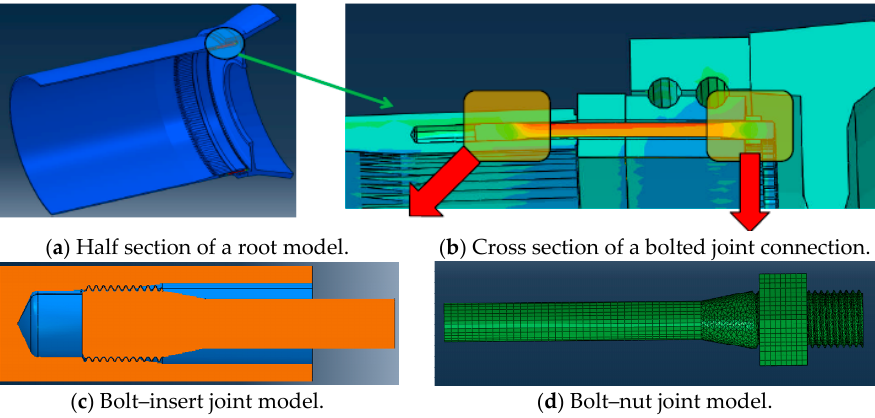
Figure 5. Schematic diagram of a blade root joint model.